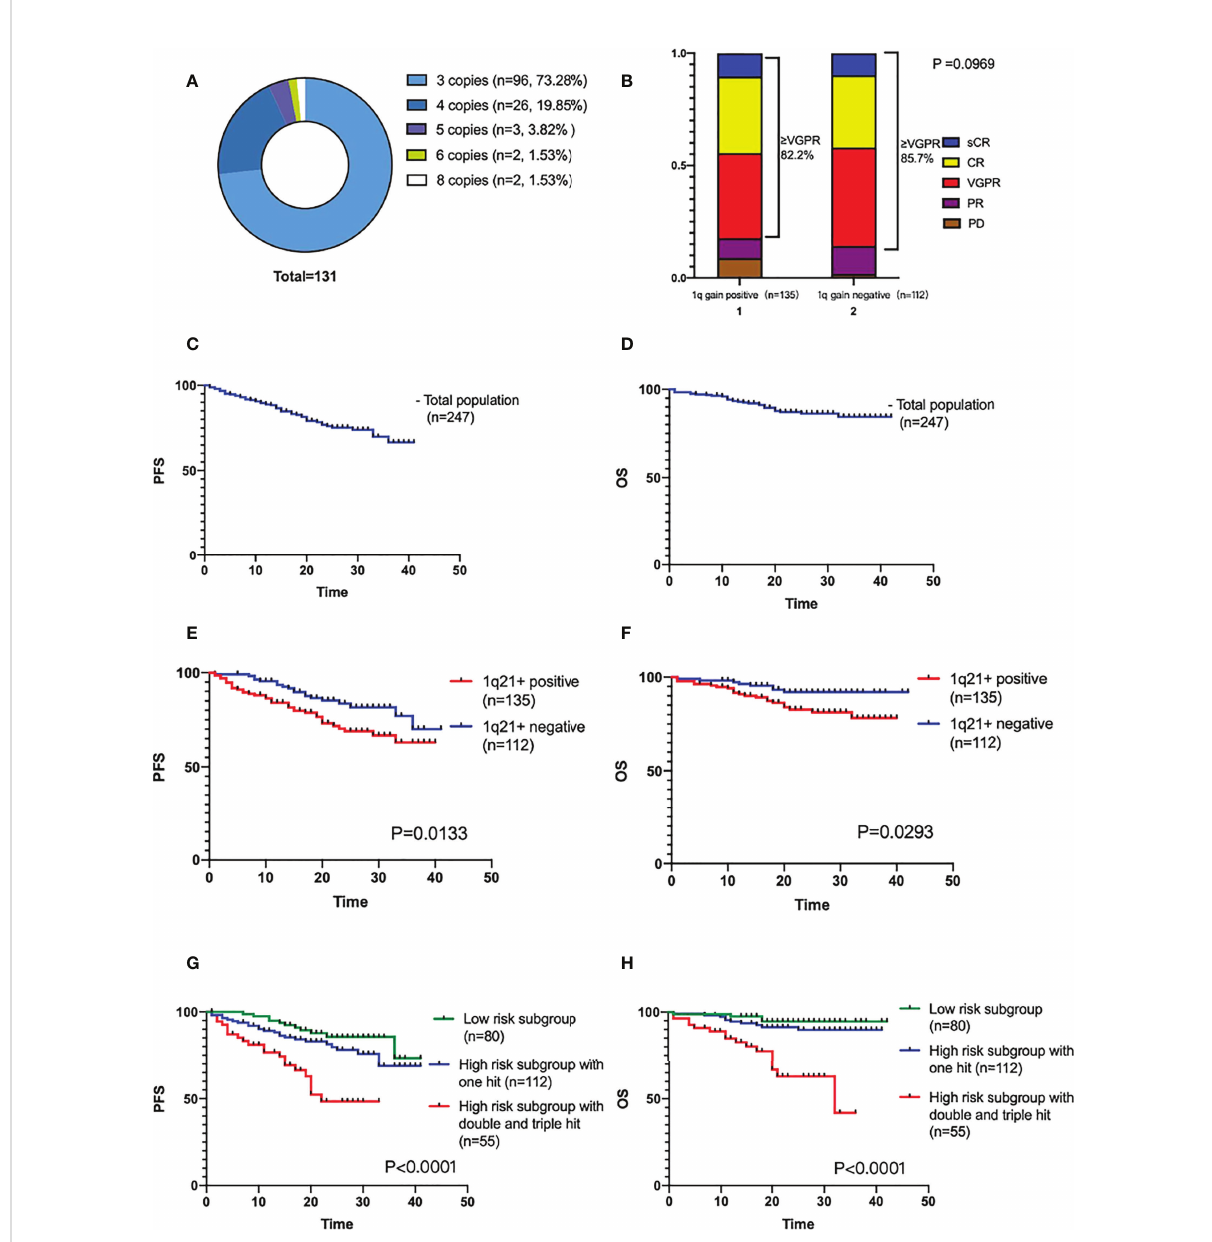
FIGURE 1 (A) Different 1q21+ positive copy numbers detected by FISH. (B) Ef fi cacy of induction therapy in patients with or without 1q21+. (C, D) The PFS and OS analysis of the total population. (E, F) The PFS and OS comparison of 1q21+ positive and negative patients. (G, H) The PFS and OS comparison by mSMART3.0 strati fi ed risk